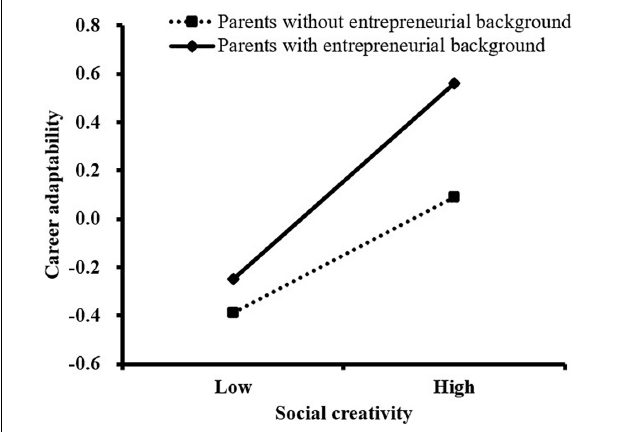
FIGURE 4 | The moderating effect of parental entrepreneurial background on the relationship between social creativity and career